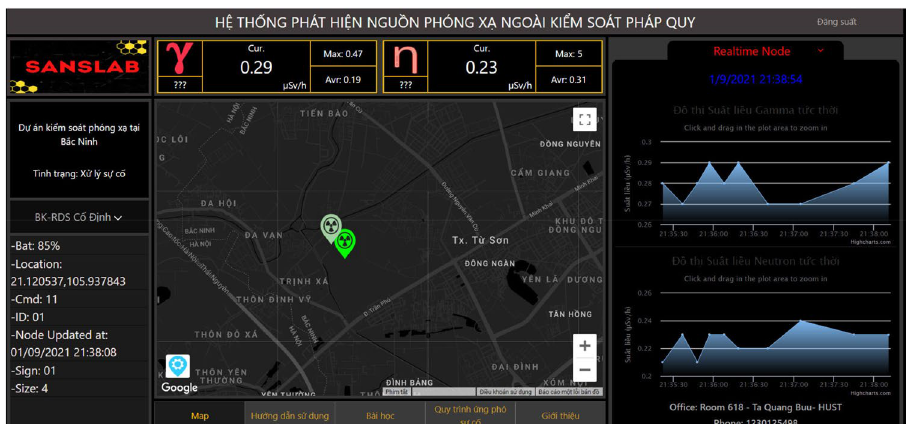
Figure 13. User application with a web-based interface, customized for Vietnamese users.